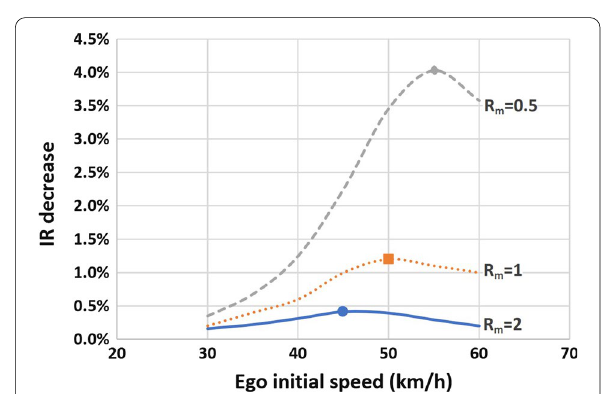
Fig. 11 IR decrease for the CCRm test with 0% offset in case of application of the CMI- V r prospective approach, as a function of the ego-vehicle initial velocity and mass